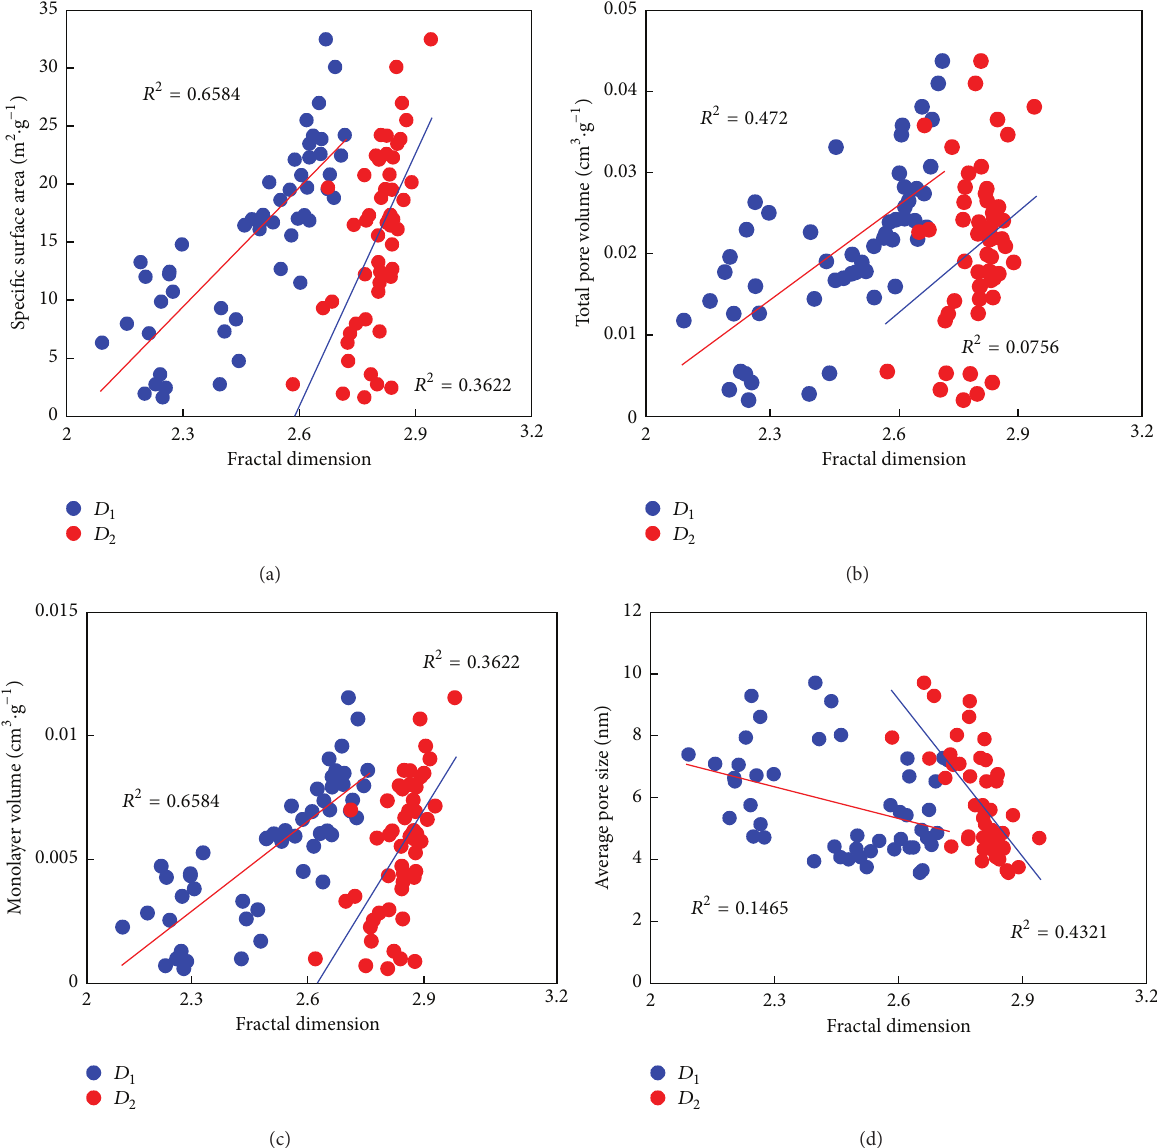
Figure 5: Relationships between fractal dimension and specific surface area (a), total pore volume (b), monolayer volume (c), and average pore size